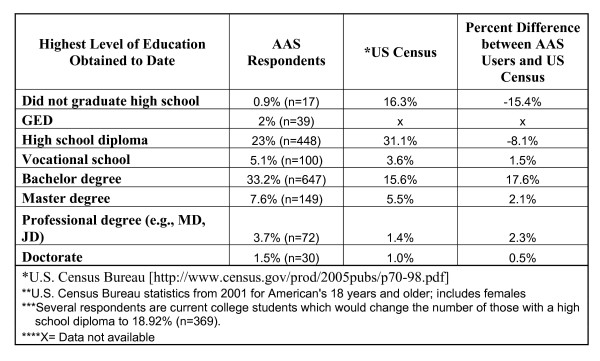
Level of Education.